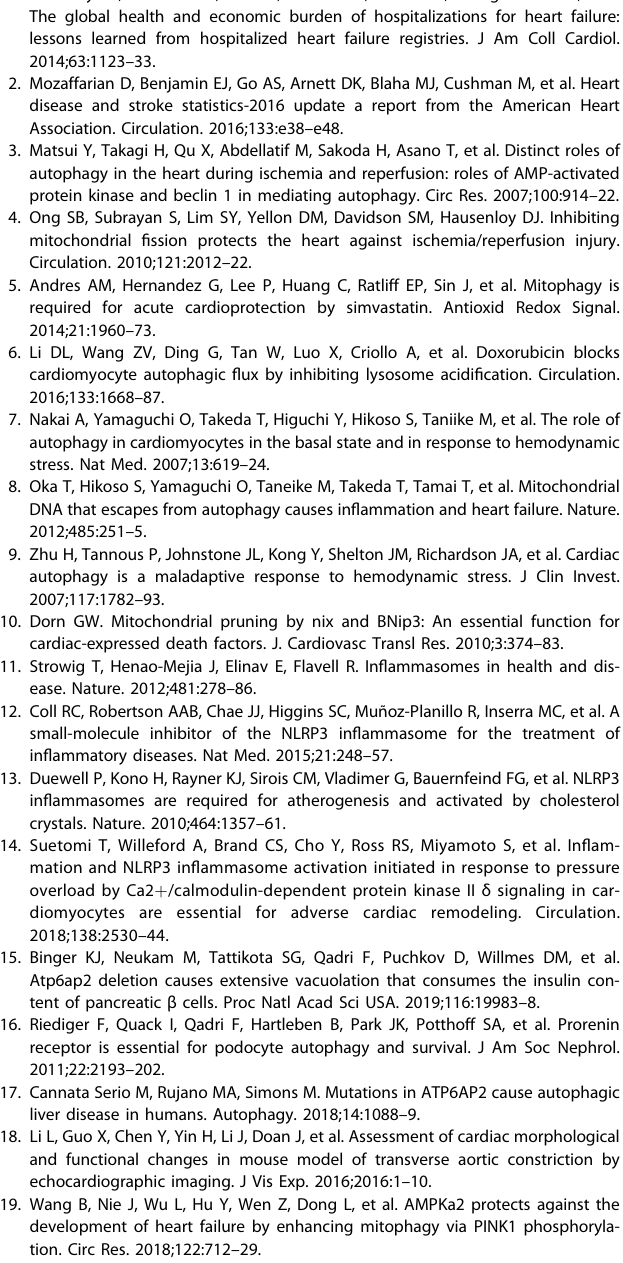
Fig. 7 Phenotype changes in shR-ATP6AP2-TAC mice can be partly relieved through blocking NLRP3 in fl ammasome activation. C57BL/6 J mice were subjected to TAC, then adenovirus-mediated shR-ATP6AP2 vectors or Scr-control were injected into the tail vein of mice ( n = 4 for each group), followed by MCC950 (5 mg/kg/day) or vehicle control. Mice were observed at 28days. A – C Representative images of echocardiograms and quantitative analysis of LVEDD, LVESD between different groups. Statistical analysis was conducted by Kruskal – Wallis one-way ANOVA with Dunn post-hoc test. *P < 0.05 compared with others. D Quantitative analysis of heart weight/body weight ratios (HW/ BW; mg/g). Statistical analysis was conducted by Kruskal – Wallis one-way ANOVA with Dunn post-hoc test. *P < 0.05 compared to other groups.